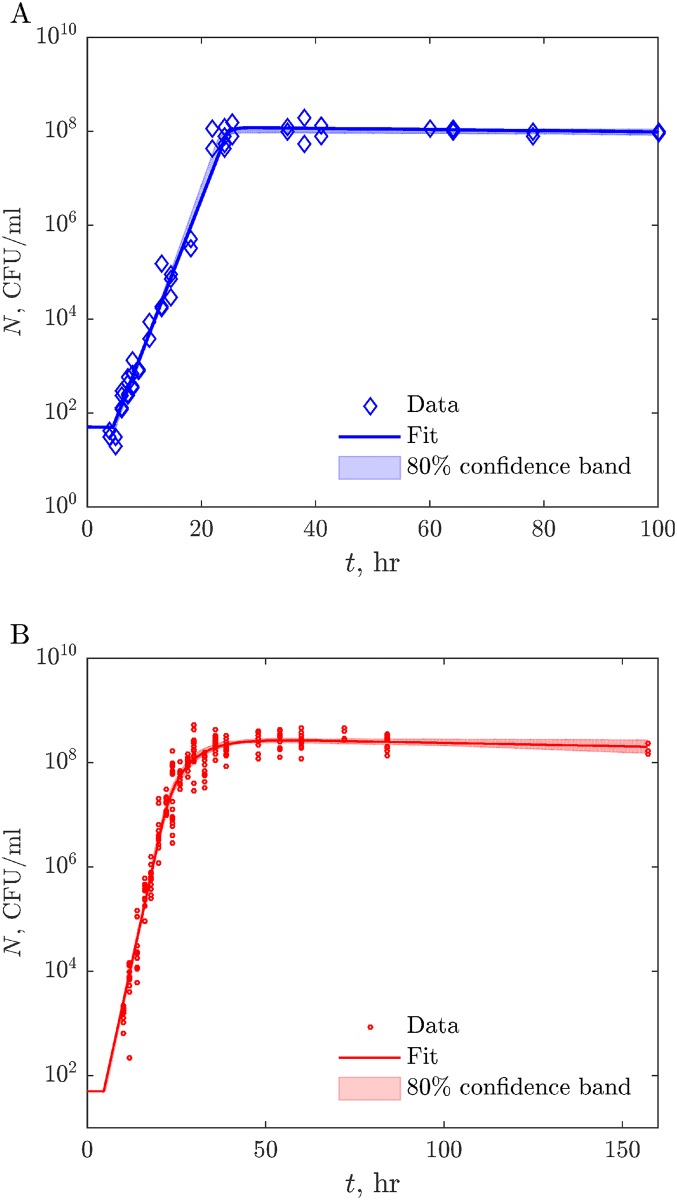
Fitting models to data.A: Liquid growth model (solid blue line) fitted to all of the experimental data we have collected (blue diamonds). 80% confidence intervals around the best-fit predictions are shown by light blue shaded bands (established by bootstrapping, with 1000 resamplings). B: same, but for 3-d colony growth. Red circles, solid red line, and light red band correspond to the data, the best fit, and the 80% confidence intervals (from 30 resamplings).